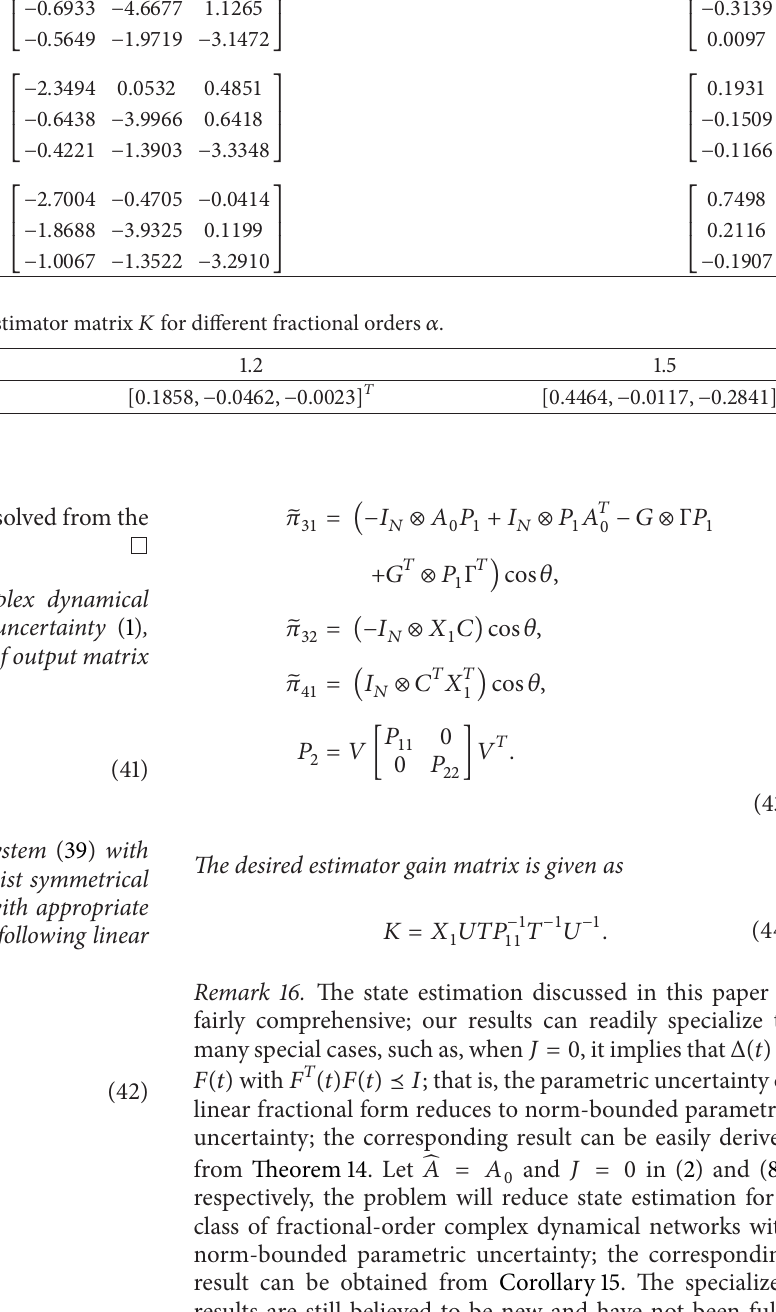
̂𝐴 and 𝐾 for different fractional orders 𝛼 .